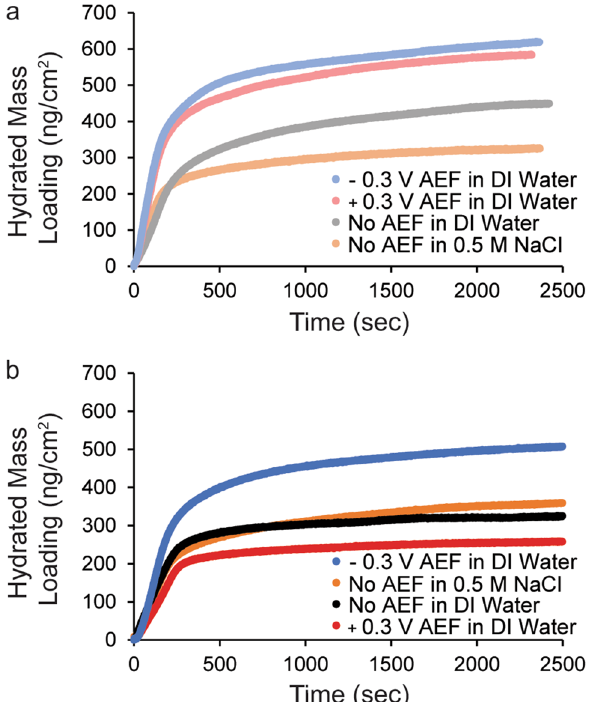
Figure 2. Assembly of charged ELP in an electric field impacts hydrated mass loading. Hydrated mass loading is monitored with time by a quartz crystal microbalance with dissipation in an electrochemical module at 20 °C as ( a ) uncharged ELP and ( b ) (−)charged ELP is assembled at four grafting conditions: (1) − 0.3 V AEF in DI water (light blue for uncharged, blue for (−)charged); (2) + 0.3 V AEF in water (light red for uncharged, red for (−)charged); (3) no AEF in water (grey for uncharged, black for (−)charged); and (4) no AEF in 0.5 M NaCl (light orange for uncharged, orange for (-)charged). All voltages are vs. a Ag/AgCl reference. Recall that the potential difference measured between the working and counter electrode, which generates the field, is − 1.0 V to − 1.1 V at − 0.3 V vs. Ag/AgCl and is − 0.2 V to − 0.3 V at + 0.3 V vs.